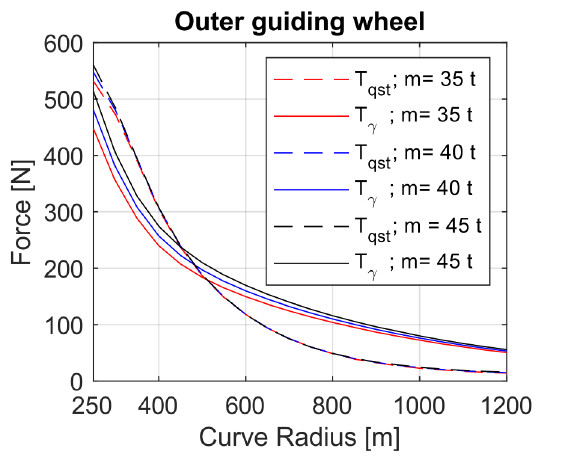
Figure 7. Dependence of the T curve radius R for defined values of the vehicle body mass m .